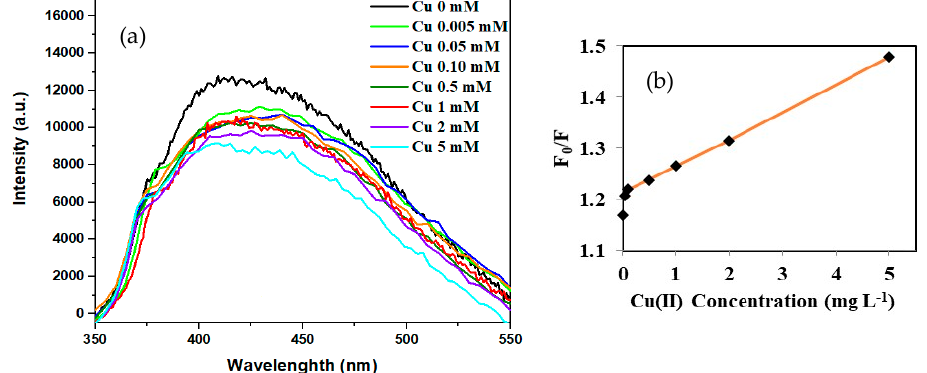
Figure 8. ( a ) Fluorescence spectra of CS-Ac-An in the presence of variable Cu(II) levels in aqueous acetic acid (2 wt%), λ ex = 330 nm. ( b ) Plot of F 0 / F against Cu(II) concentration (Stern-Volmer equation).